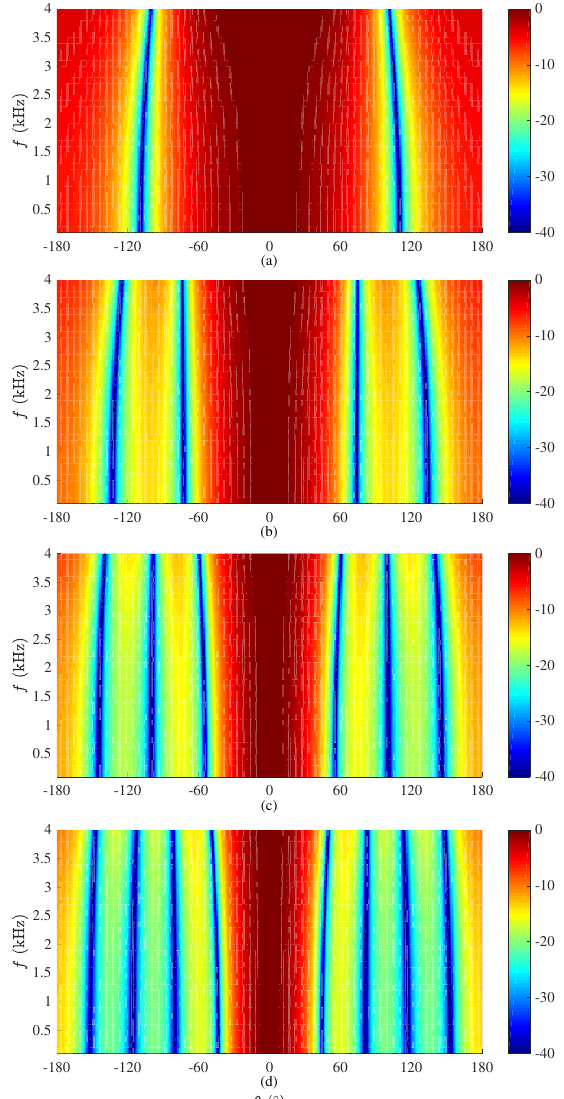
Figure 4. Beampatterns of the binaural heterophasic superdirective beamformer as a function of the frequency with different numbers of microphones: ( a ) M = 6, ( b ) M = 8, ( c ) M = 10, and ( d ) M = 12. Conditions of simulation: δ = 1.0 cm and N = M /2.